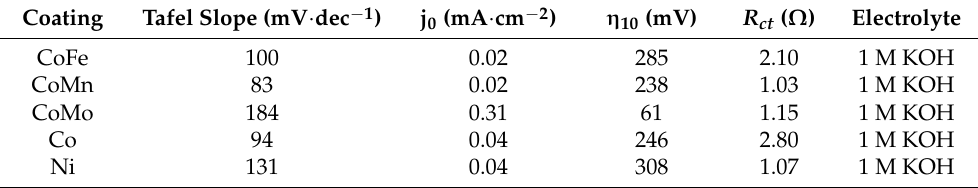
Table 3. Electrochemical performance of the tested coatings toward HER in alkaline media. Tafel Slope Coating